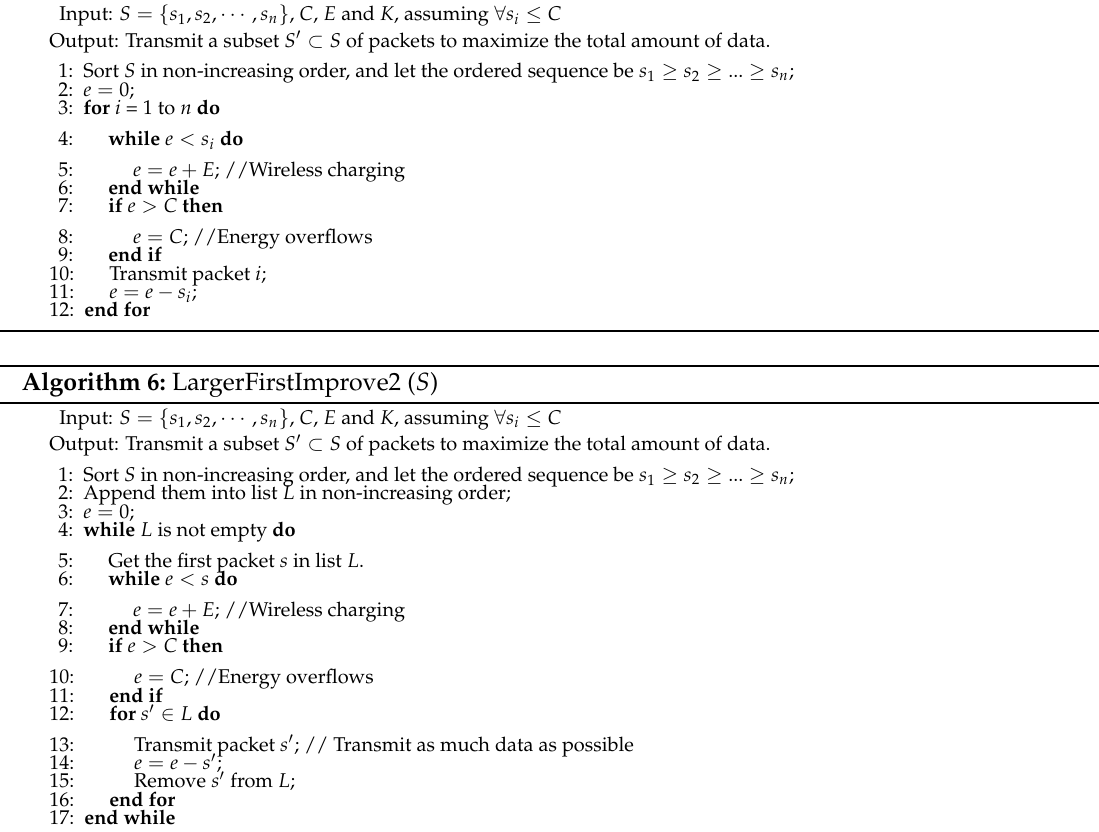
Algorithm 5: LargerFirst2 ( S )